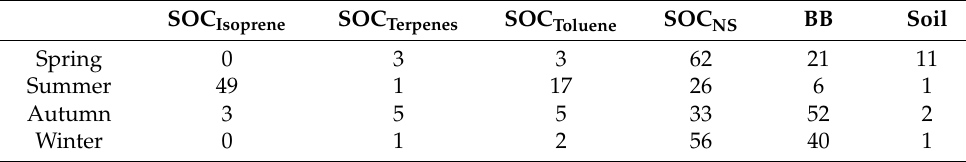
Table 6. Contributions of different sources to WSOC by PMF in different seasons (%). SOC Isoprene SOC Terpenes SOC Toluene SOC NS BB Soil Spring 0 3 3 62 21 11 Summer Autumn Winter 0 1 56